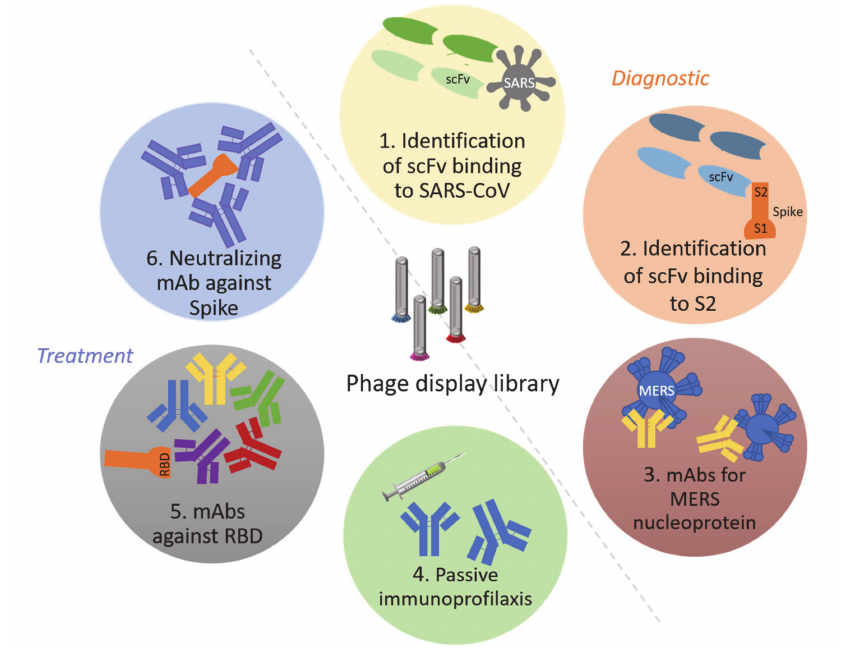
Figure 1. Uses of phage-display libraries in the diagnostic (1, 2 y 3) and treatment (4, 5, and 6) of SARS-CoV-2. scFv: single-chain variable fragment. S2: spike subunit 2. mAbs: monoclonal antibodies. MERS: Middle-East respiratory syndrome. RBD: receptor-binding